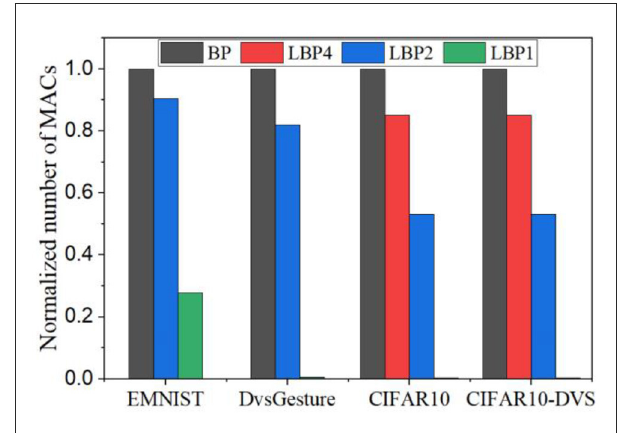
FIGURE13 Normalized number of MACs estimated for training different networks averaged over training time windows for one batch iteration. For each task, the number of MACs was normalized over that required by BP.